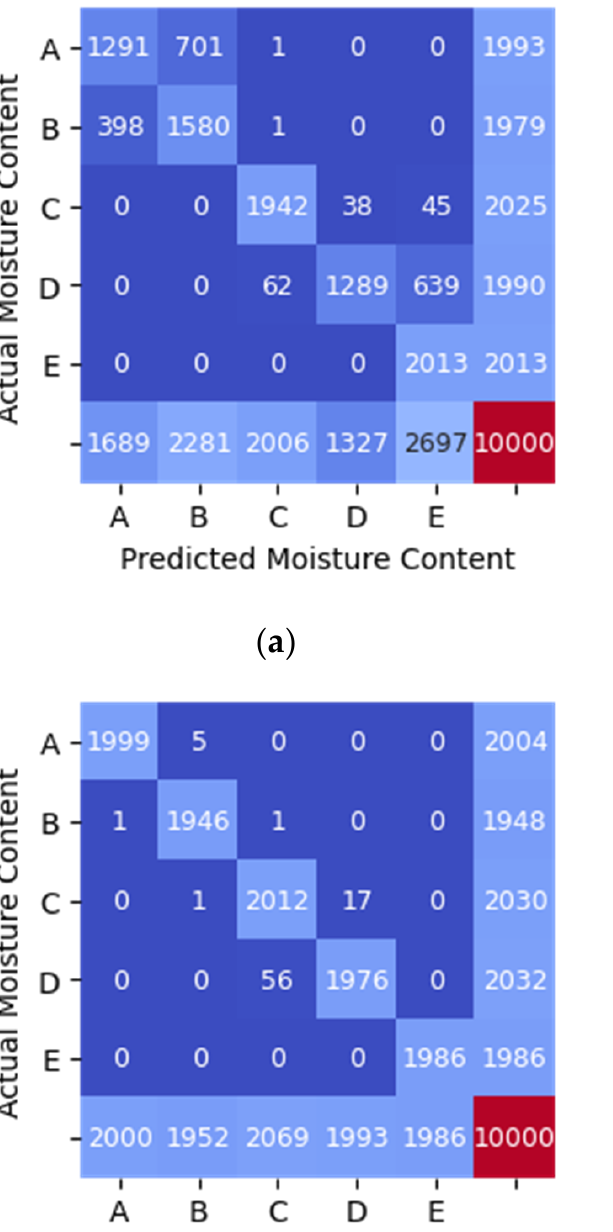
Table 6. Performance of different algorithms for RSSI_WSN data.